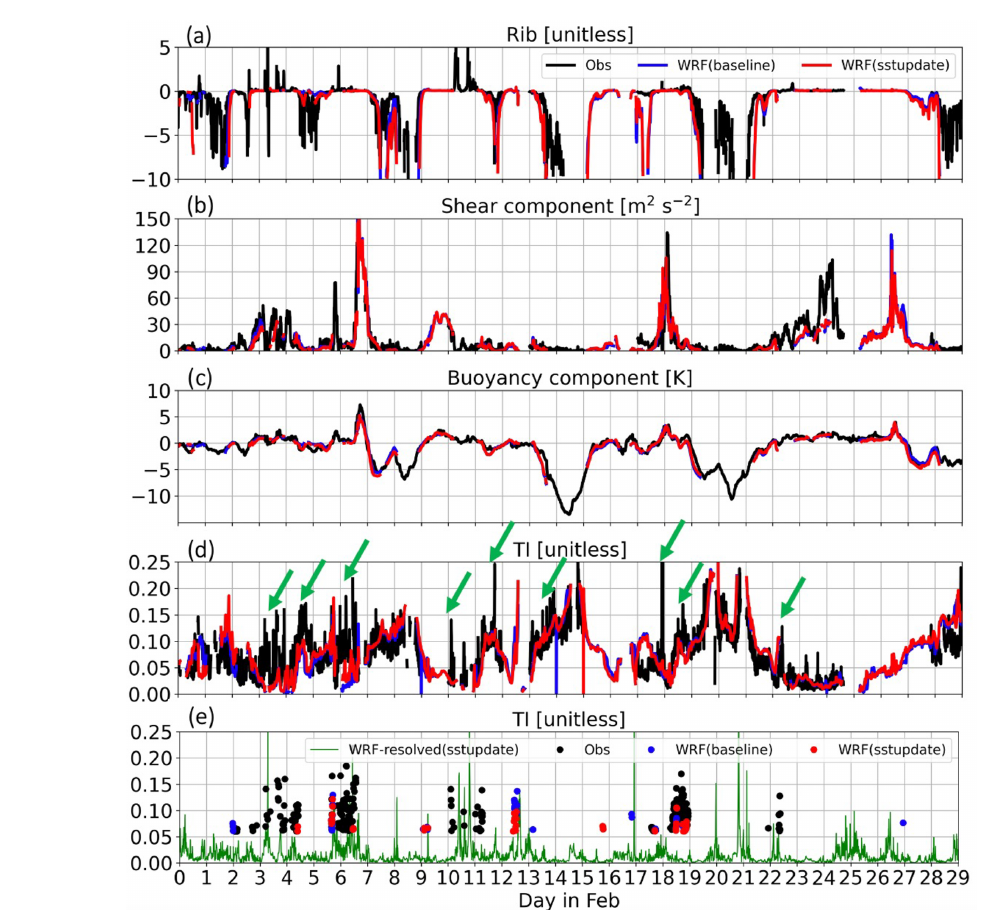
Figure 10. Time-series plots of observed and simulated (a) bulk Richardson number, (b) shear component (m 2 s − 2 ), (c) buoyancy com- ponent (K), and (d) sub-grid turbulence intensity (TI) during February 2020. Green arrows in (d) indicate events with large contrast in TI between the model and observation. Filtered data points of sub-grid TI by using the thresholds of buoyancy > 0K, shear < 20.0m 2 s − 2 , and TI > 0.06 are denoted in (e) . The green line represents the model-resolved